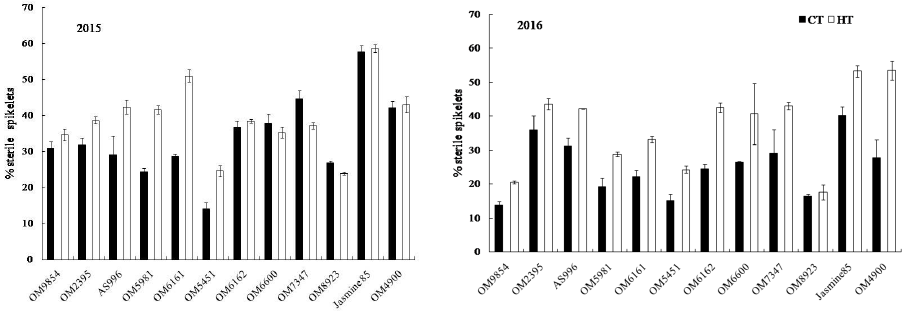
Figure 4. Effect of high temperature on the percentage of sterile spikelets in 2015 and 2016. Vertical bars indicate SD of means ( n = 3).